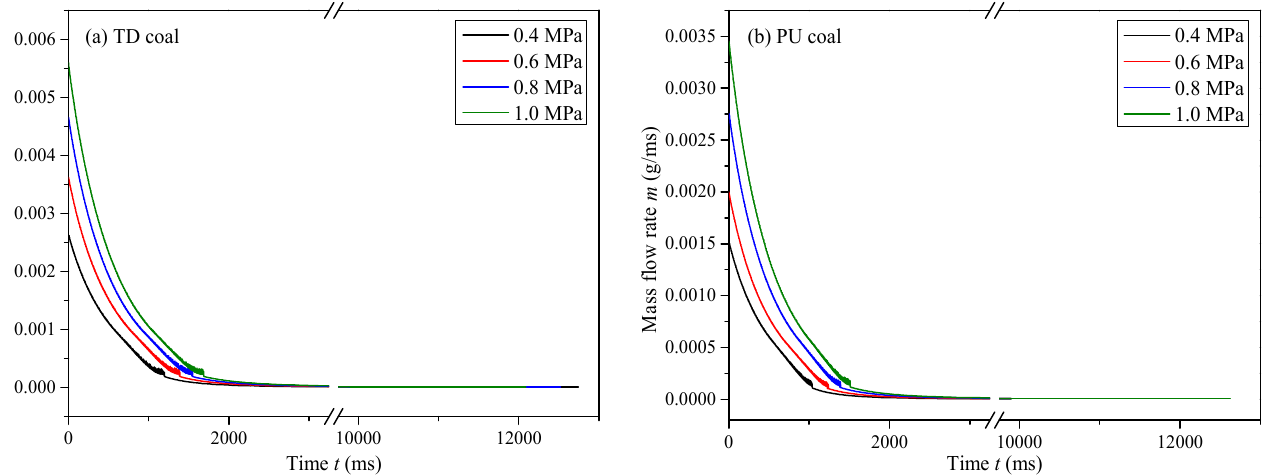
Figure 7. Correlation of the mass flow rate vs. gas pressure at the initial time. 3.4. Gas Velocity Change It is generally believed that the main energy sources come from elastic potential en- ergy exerted by in situ stress and gas energy of the coals during an outburst process. The